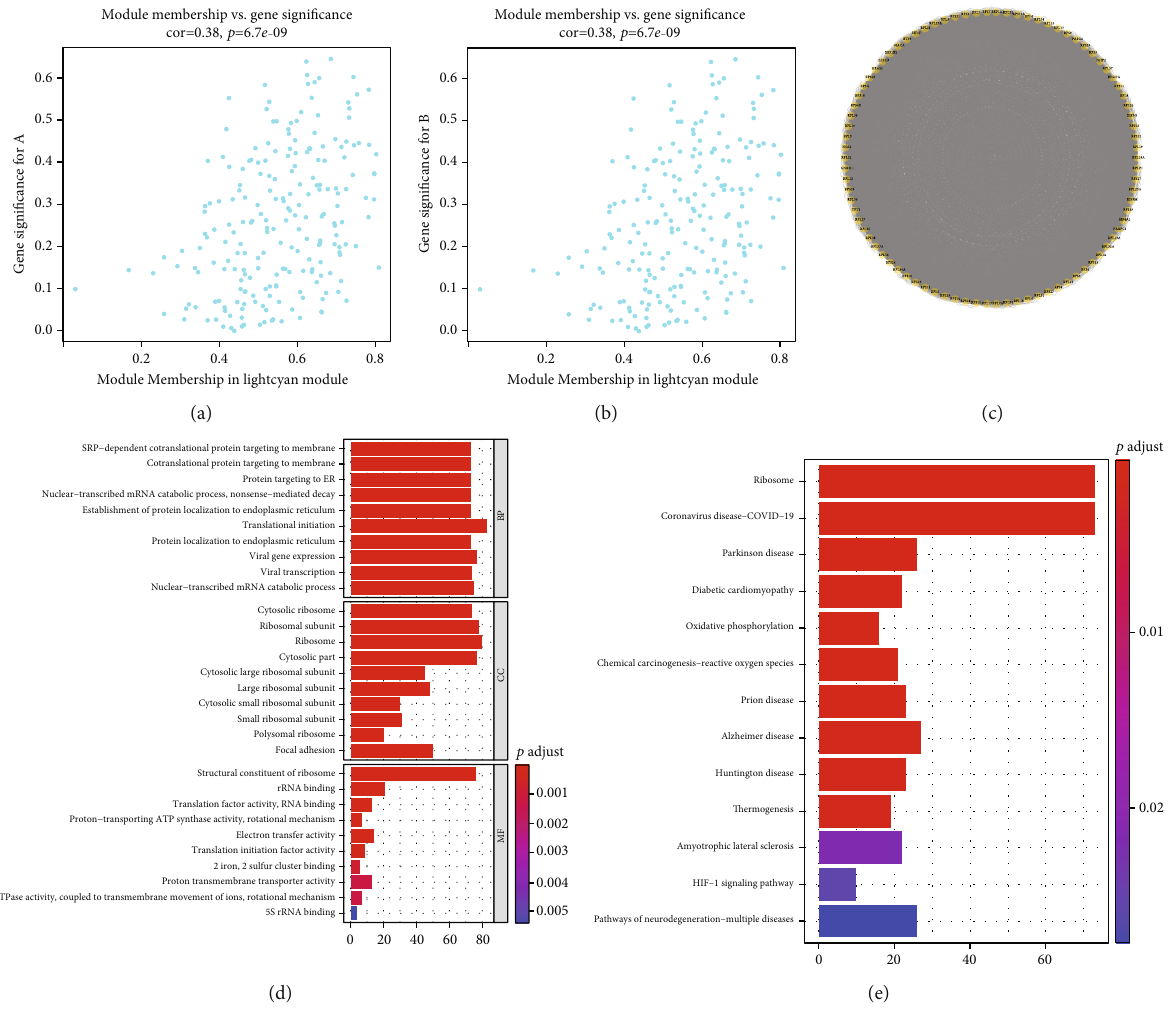
Figure 5: Exploration of EMT-derived genes and their relevant biological implication. (a) Scatter plots depict the interactions of module membership and gene signi fi cance for EMT subtype A. (b) Scatter plots display the interactions of module membership and gene signi fi cance for EMT subtype B. (c) The PPI network uncovers the EMT-derived hub genes through MCODE analyses. (d, e) GO and KEGG pathway enrichment analyses of EMT-derived hub